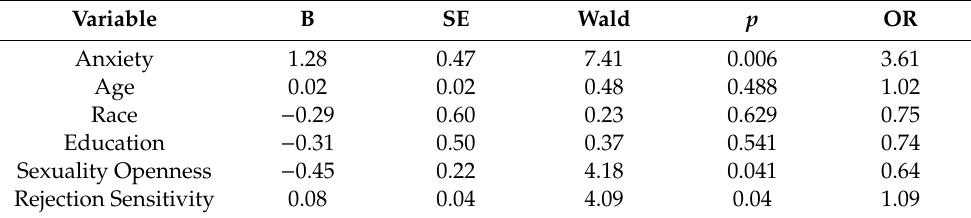
Table 4. Logistic regression analysis on the presence of depression symptoms.